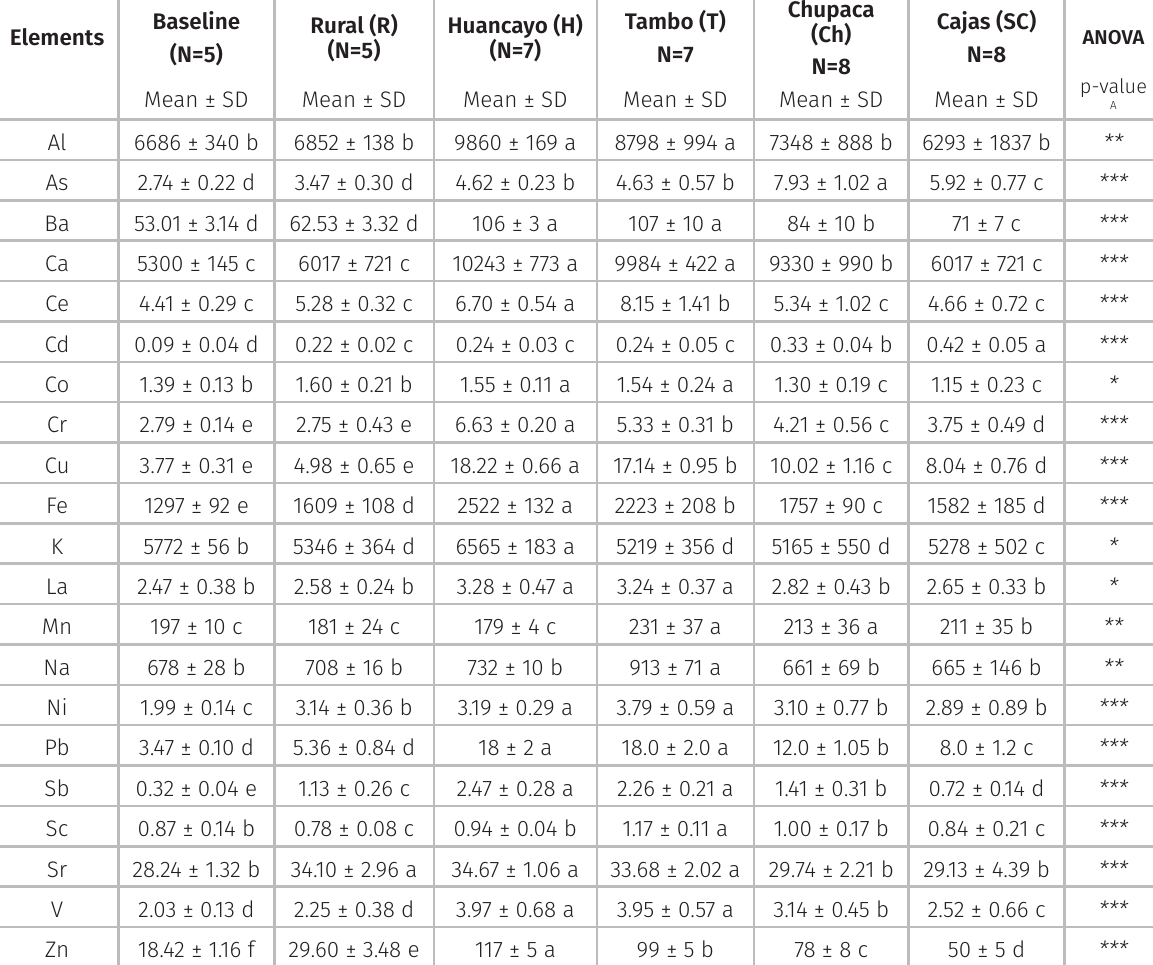
Table III. Mean concentrations ± standard deviation S.D. (ug g -1 dry weight (D.W)) and ANOVA results of the 21 elements measured in T. capillaris samples exposed during 3 months in the study area and control samples; N = number of